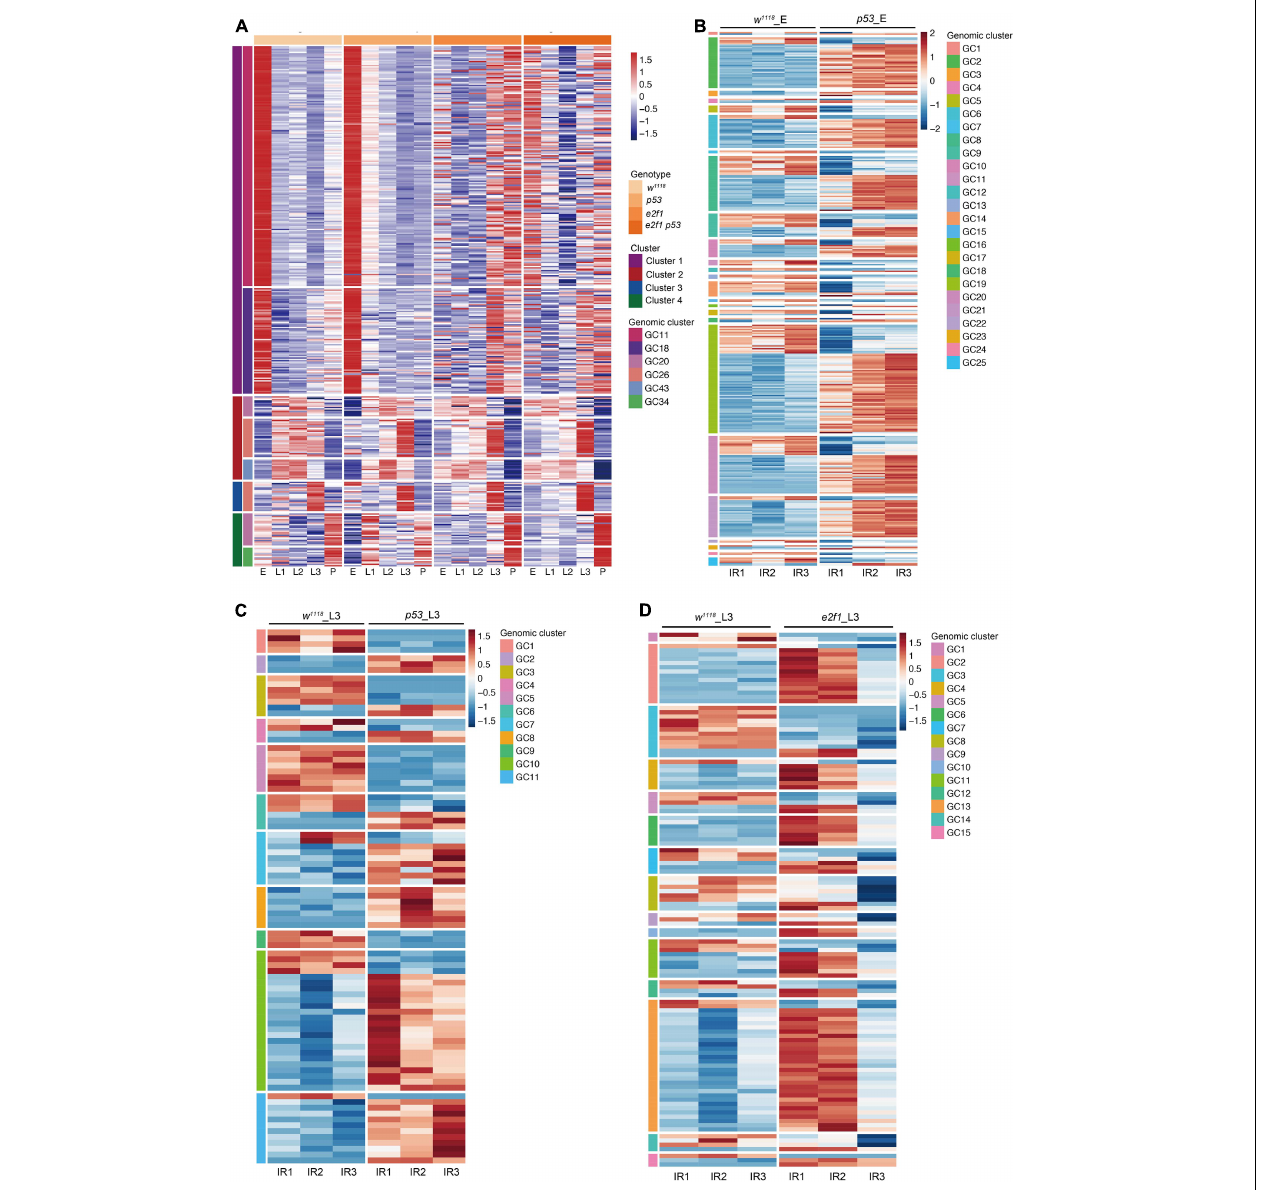
FIGURE 7 | Expression of piRNA clusters during development and after X-ray irradiation. (A) Representative illustration of heatmap of piRNA genomic clusters during development. (B) Heatmap of DE piRNA clusters after X-ray irradiation in p53 mutant embryos. (C) Heatmap of DE piRNA clusters after X-ray irradiation in p53 mutant L3. (D) Heatmap of DE piRNA clusters after X-ray irradiation in e2f1 mutant